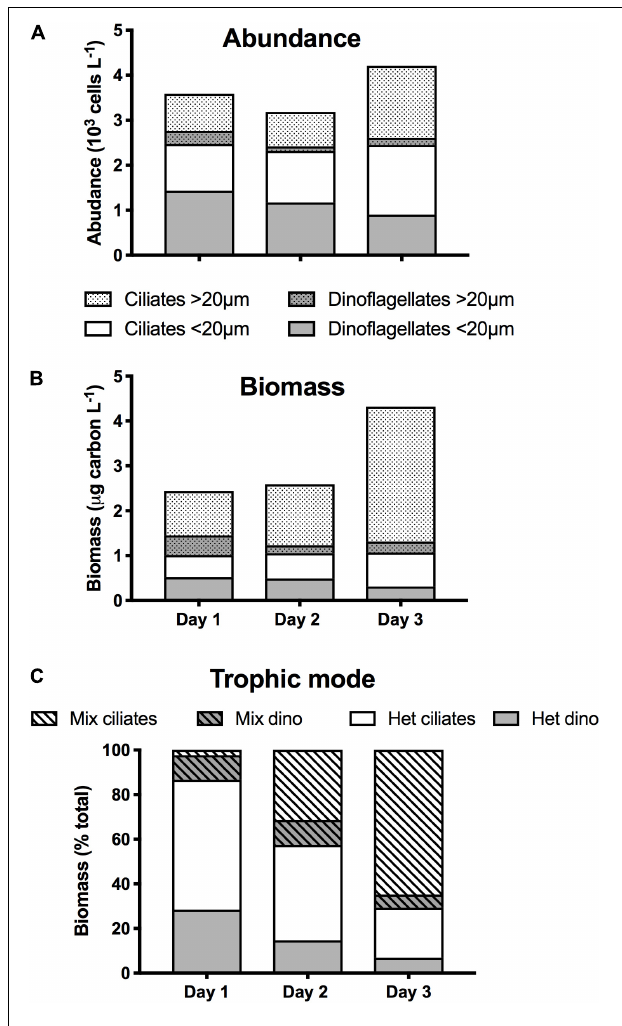
FIGURE 3 | Microzooplankton community composition during the first 3 days of occupation of station 4 during NAAMES II: Size distribution of ciliates and dinoflagellates in terms of (A) abundance (10 3 cells L − 1 ); (B) biomass ( µ g C L − 1 ); (C) Contribution (%) of ciliates and dinoflagellates as a function of their trophic mode (Mix, mixotrophy; Het, heterotrophy).